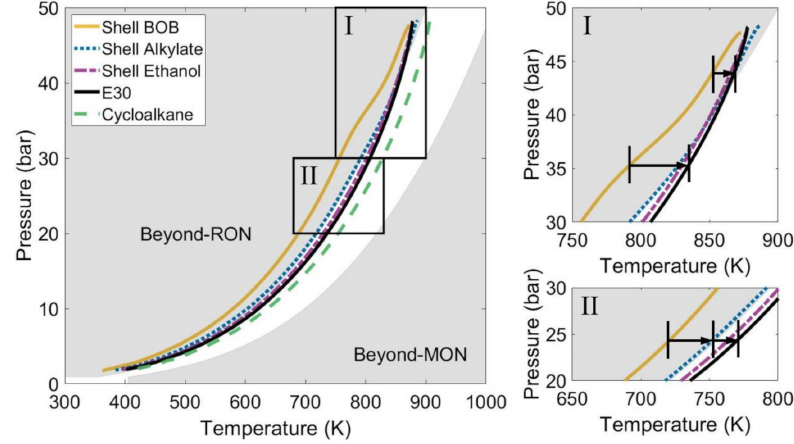
Figure 8. Pressure-Temperature trajectories for PFS operation at 10 ◦ CA phasing. Pressure-temperature trajectories for SACI operation begin at intake valve closing and